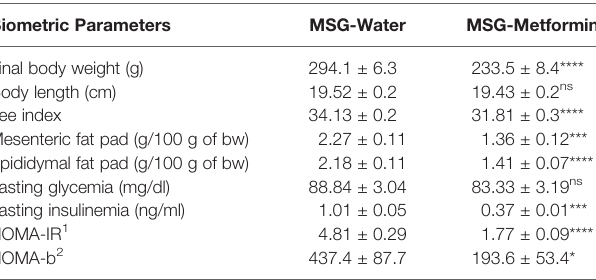
TABLE 1 | Biometric parameters of the monosodium L-glutamate (MSG) rats treated or no with metformin. Biometric